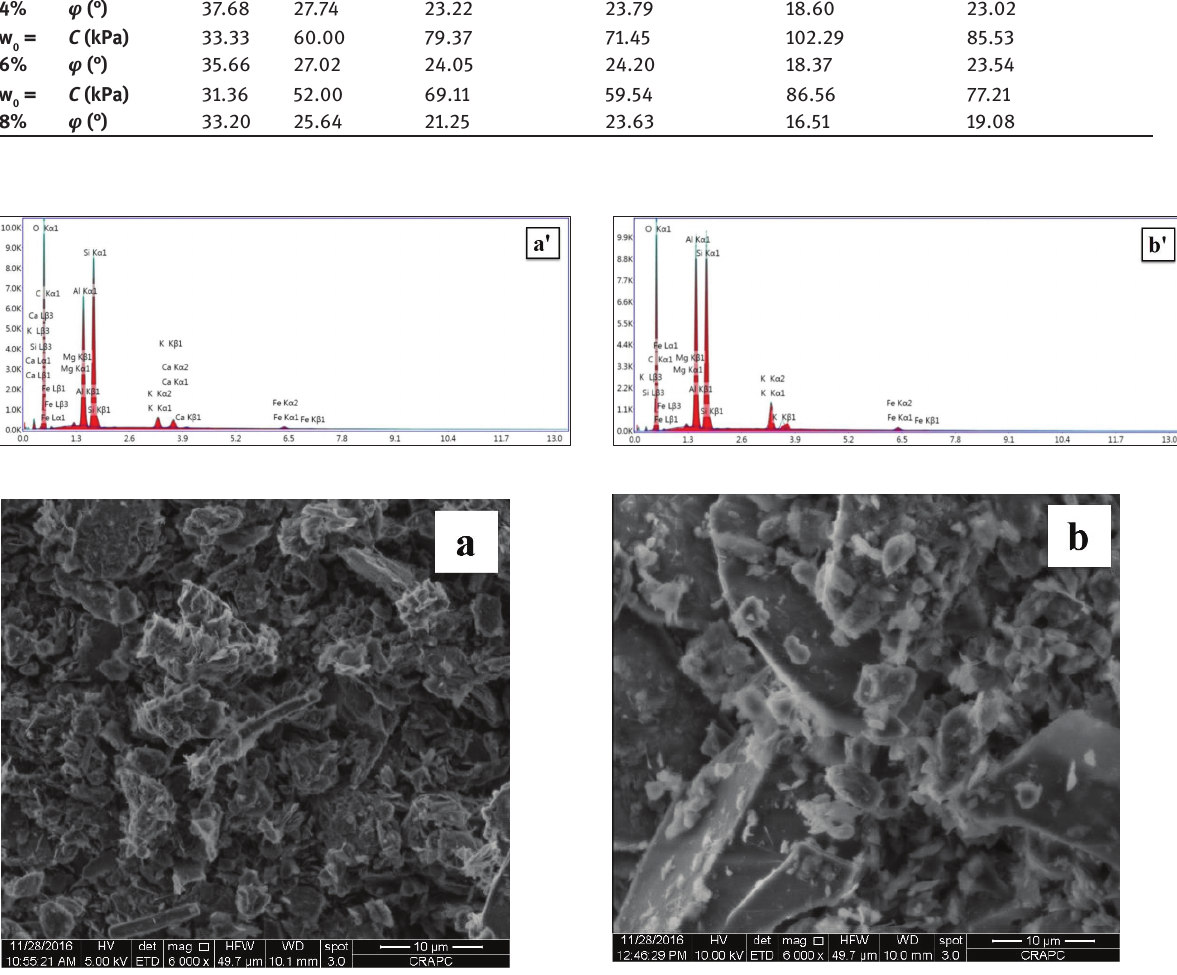
Figure 7: SEM and EDS analyses of control soil (SNT) without